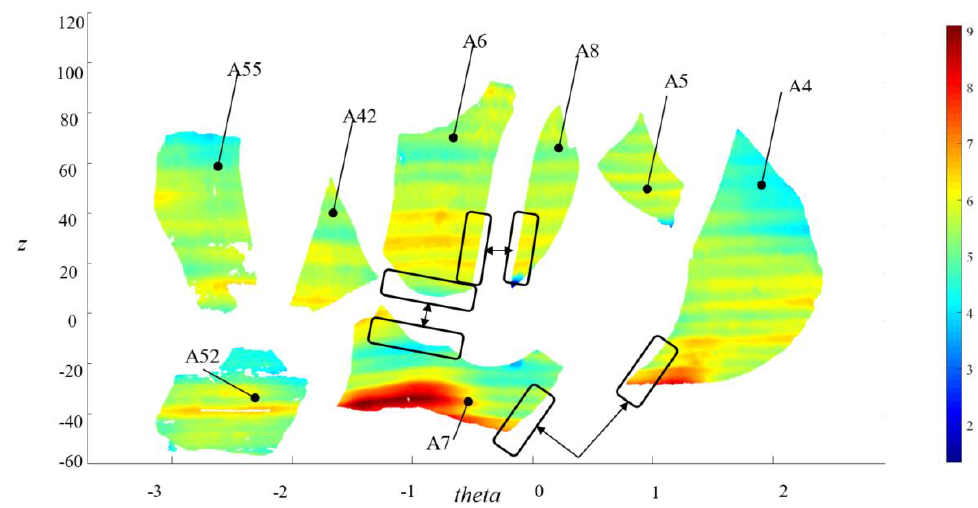
Figure 12. Software interface for pottery reconstruction: matching of the fragments’ profiles.